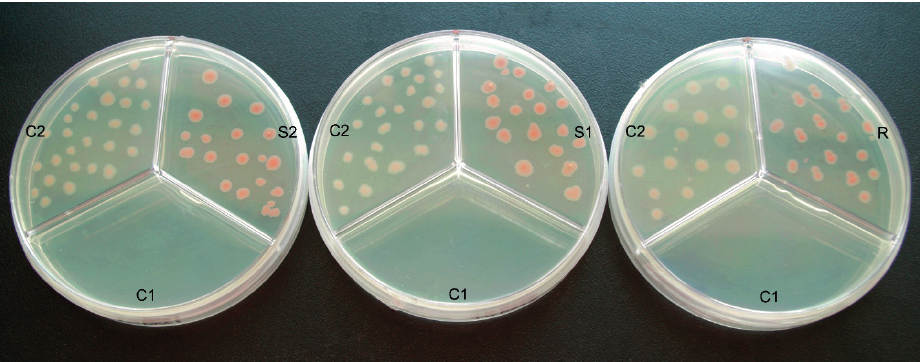
Figure 4. Functional identification of TwDXS1 , TwDXS2 , and TwDXR in E. coli Trans1-Blue cells. The pTrc- TwDXS1 (S1), pTrc- TwDXS2 (S2) and pTrc- TwDXR (R) were